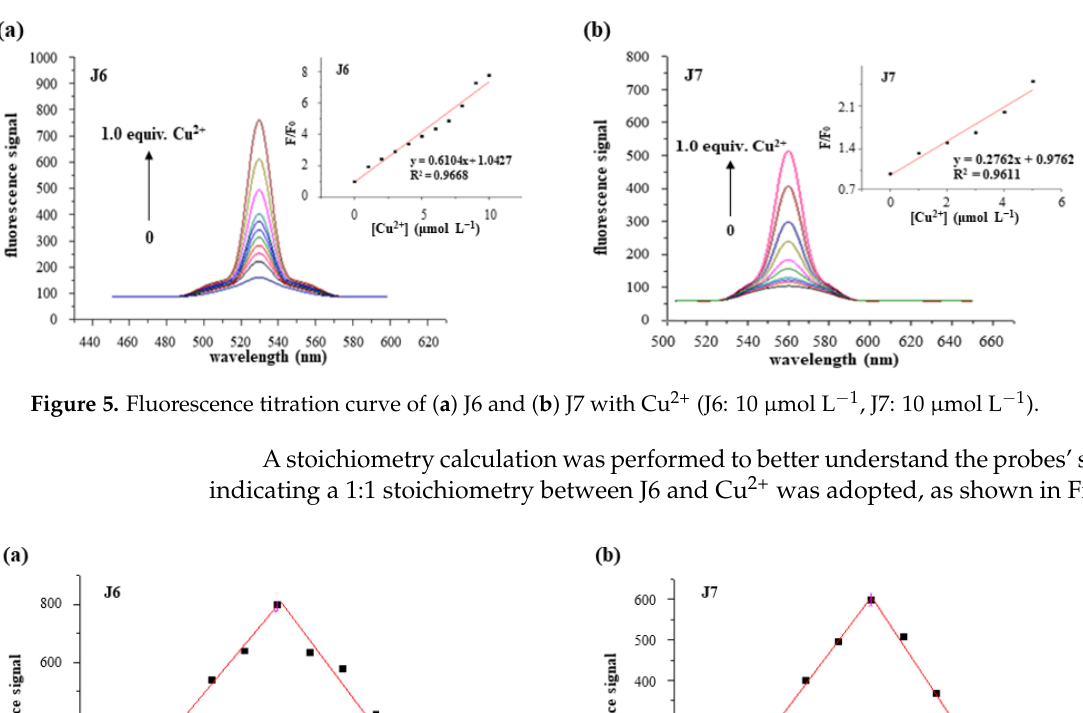
L −1 (Figure 5, (b), inset) based on Stern-Volmer Equation could be expressed as y = 0.2762x + 0.9762 (R 2 = 0.9611), with a Cu 2+ detection limit of 0.977 μmol L −1 and the association